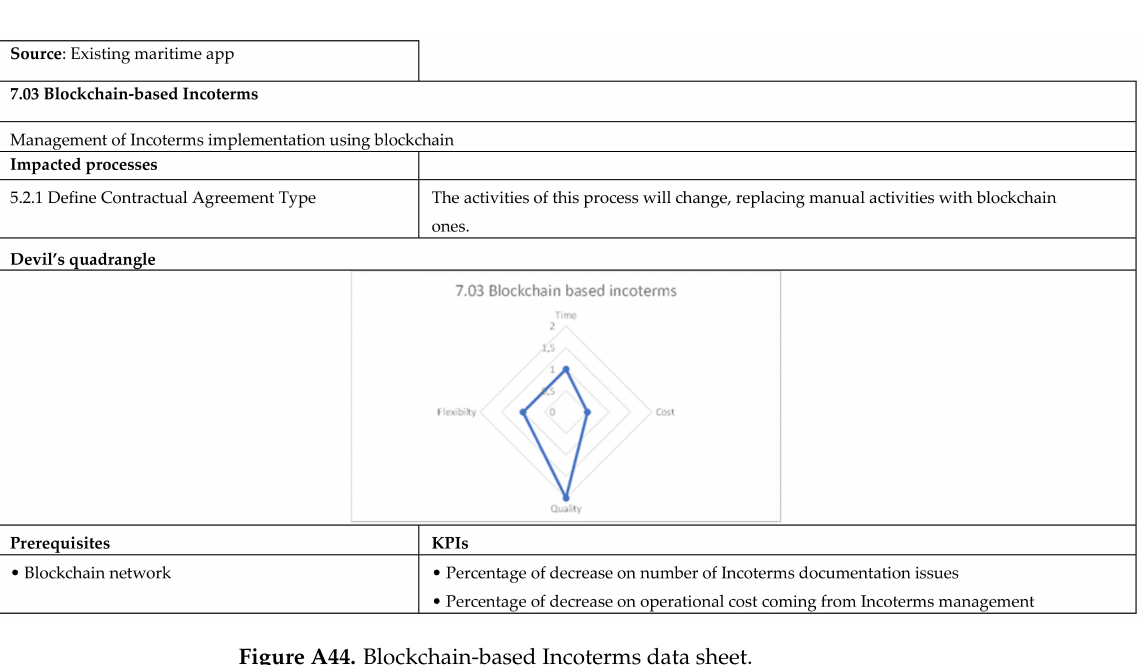
Figure A43. Cargo documents management data sheet.